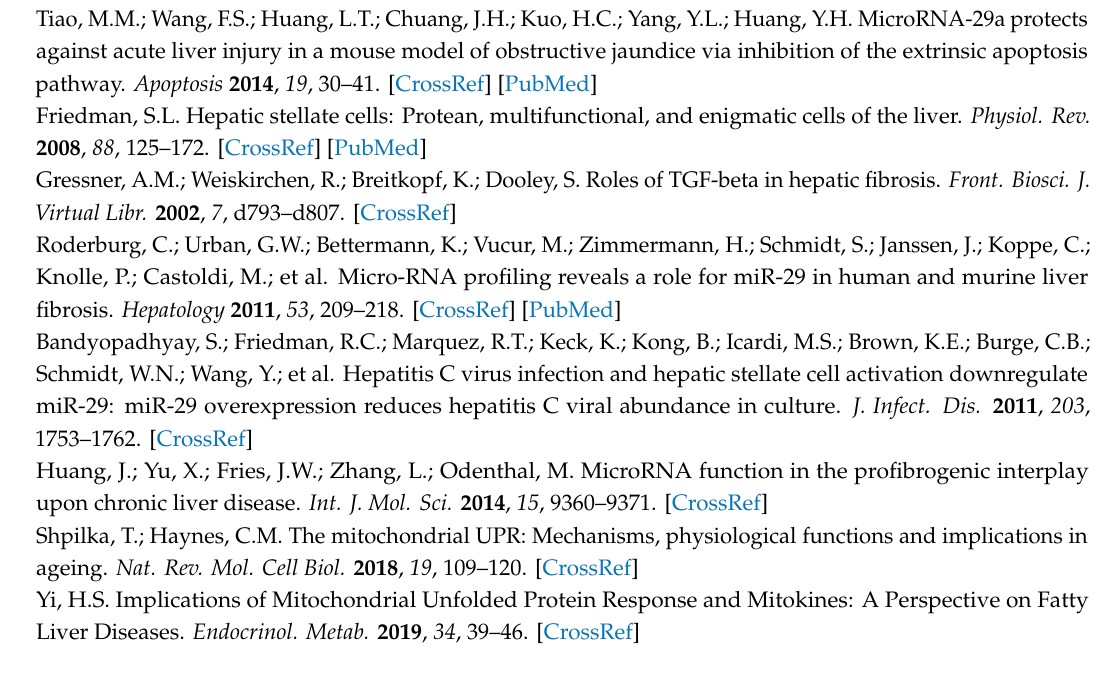
Figure S1. Dose optimization of miR-29a mimic, Figure S2. PCR e ffi ciency of col1 α 1 , il-1 β , tgf- β 1 , and gapdh